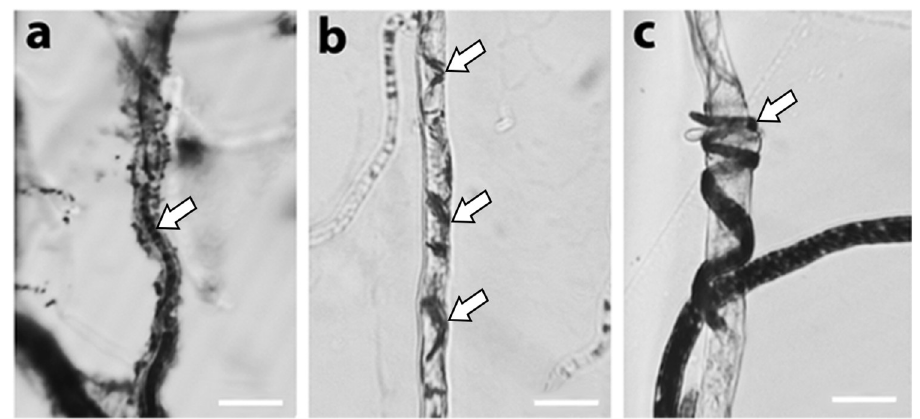
Fig 2. Microscopic examination of confrontation zones between C . rosea 100C/1 strain and GTD pathogens. Parasitism of C . rosea on D . ampelina ( a ) and B . dothidea ( b,c ) hosts after staining with 5 mM MTT for one hour. Arrows mark C . rosea mycelia. Scalebars represent 10 μ m.